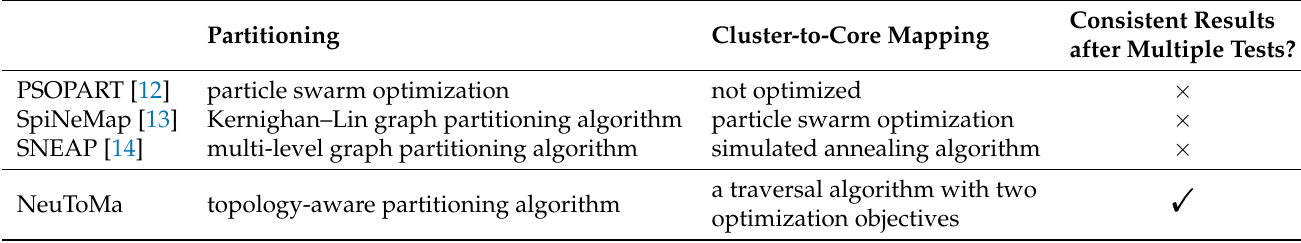
Table 1. NeuToMa versus state-of-the-art